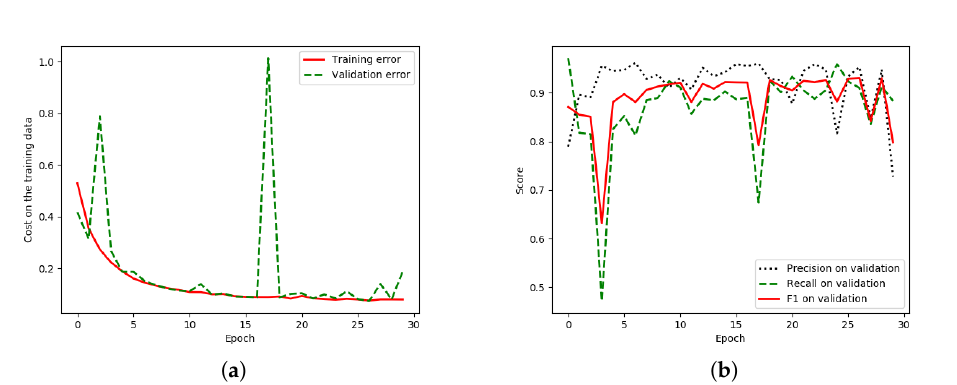
Figure 21. Graph (learning curves) in ISPRS data set of the baseline approach, GCN152-TL-A [12]; x refers to epochs, and y refers to different measures ( a ) Plot of model loss (cross-entropy) on training and validation corpora; ( b ) performance plot on the validation